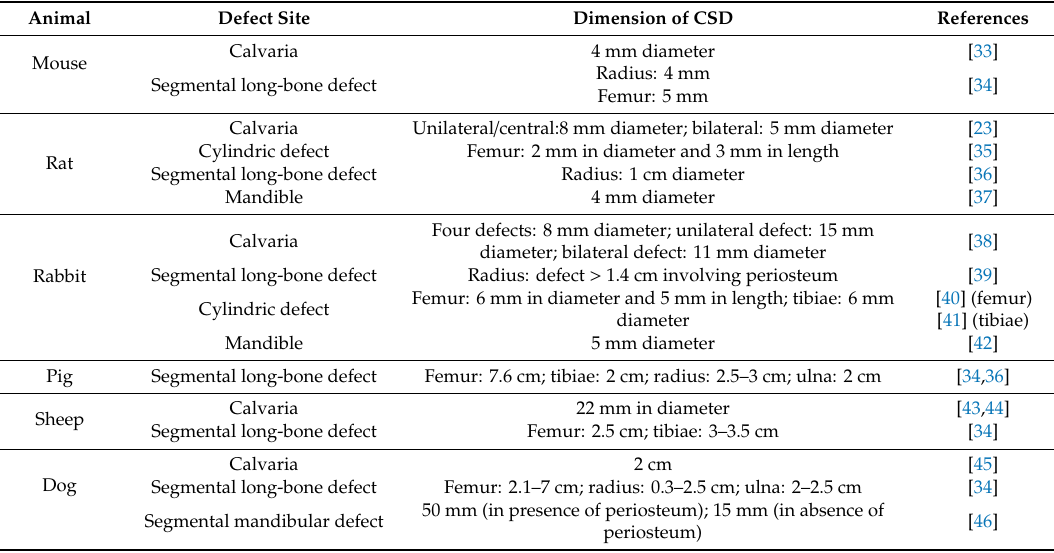
Table 1. Definition of critical-sized bone defect